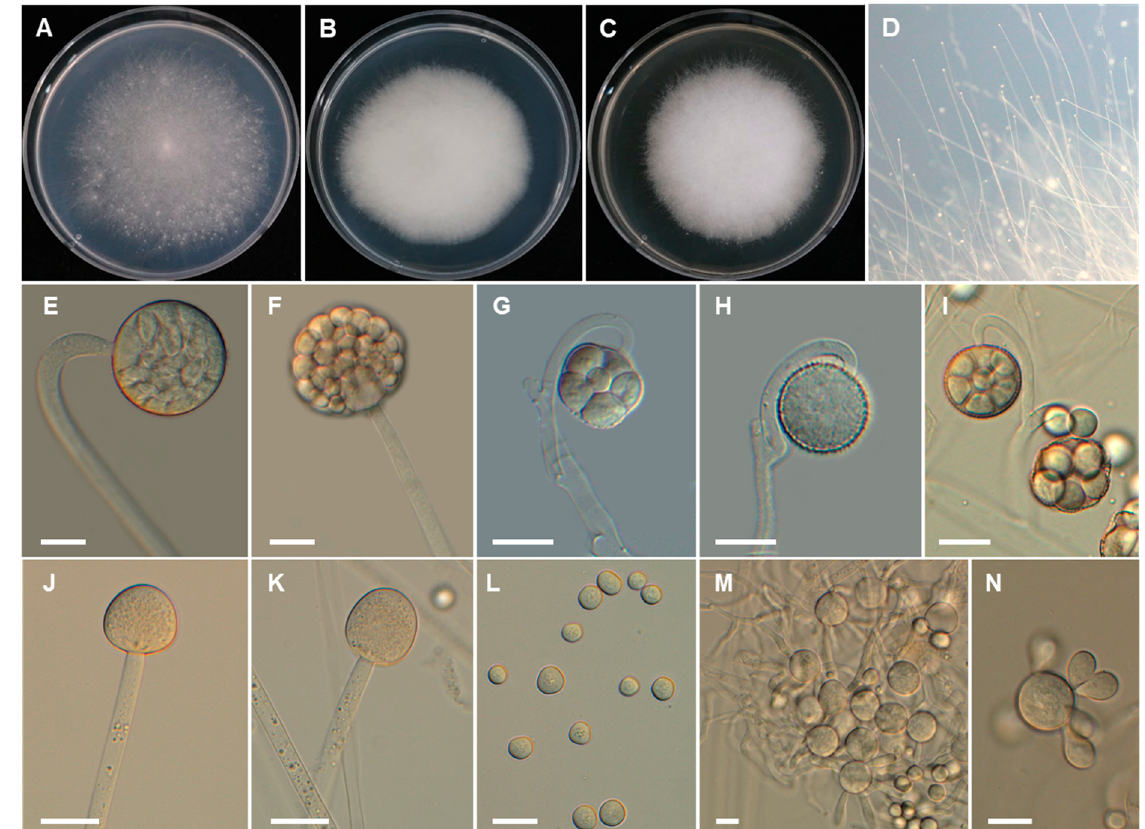
Figure 4. Morphology of Backusella koreana . A , Colony on SMA. B , Colony on PDA. C , Colony on MEA. D , Sporangiophores forming sporangia. E , F , Sporangia. G , Multi-spored sporangiolum. H , Uni-spored sporangiolum. I , Multi-spored sporangiola borne on circinate branches. J , K , Columellae of different shapes. L , Sporangiospores. M , N , Yeast-like cells. Scale bars = 20 μ m.